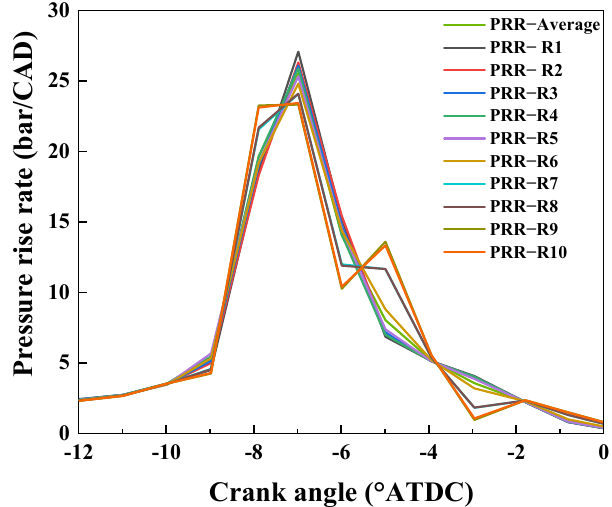
Figure 8. Pressure rise rate of the ten regions under B20 working conditions.